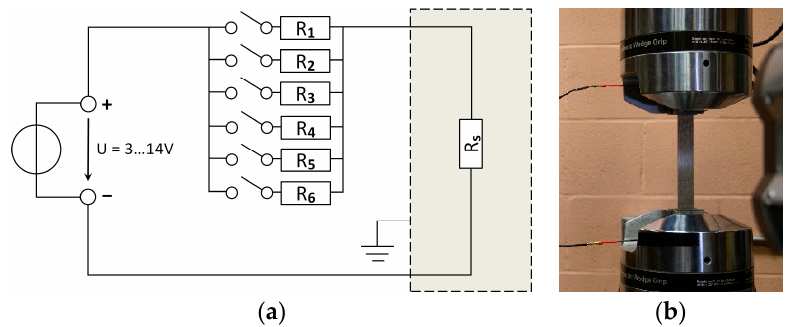
Figure 9. ( a ) Electrical circuit diagram used for applying the electrical loads, where R 1 to R 6 are power resistors and R S represents the specimen; ( b ) specimen installation with electrical wiring.